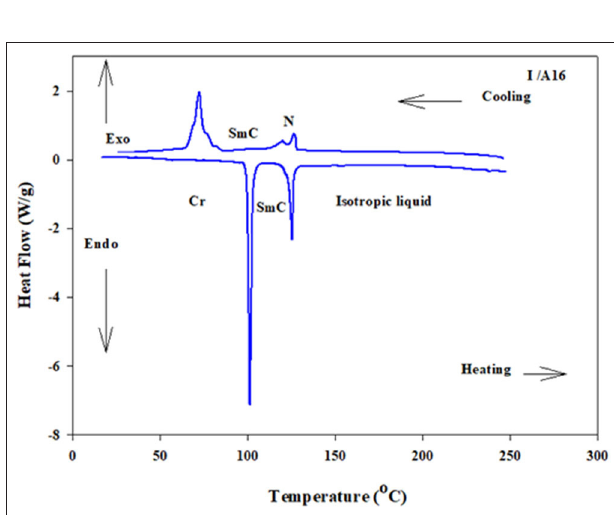
FIGURE 3 | DSC thermograms upon the second heating/cooling cycles of 1:2 SMHBC I/A 16 with a heating rate of 10 ◦ C/min.